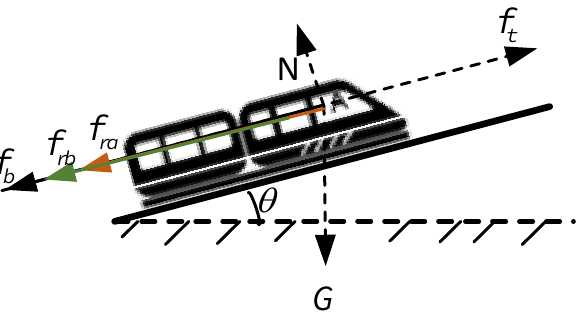
Figure 1. Schematic diagram of the force of the train. The total force F on the train along the running direction is mainly composed of four parts: traction force f t , braking force f b , basic resistance f rb and additional resistance f ra .